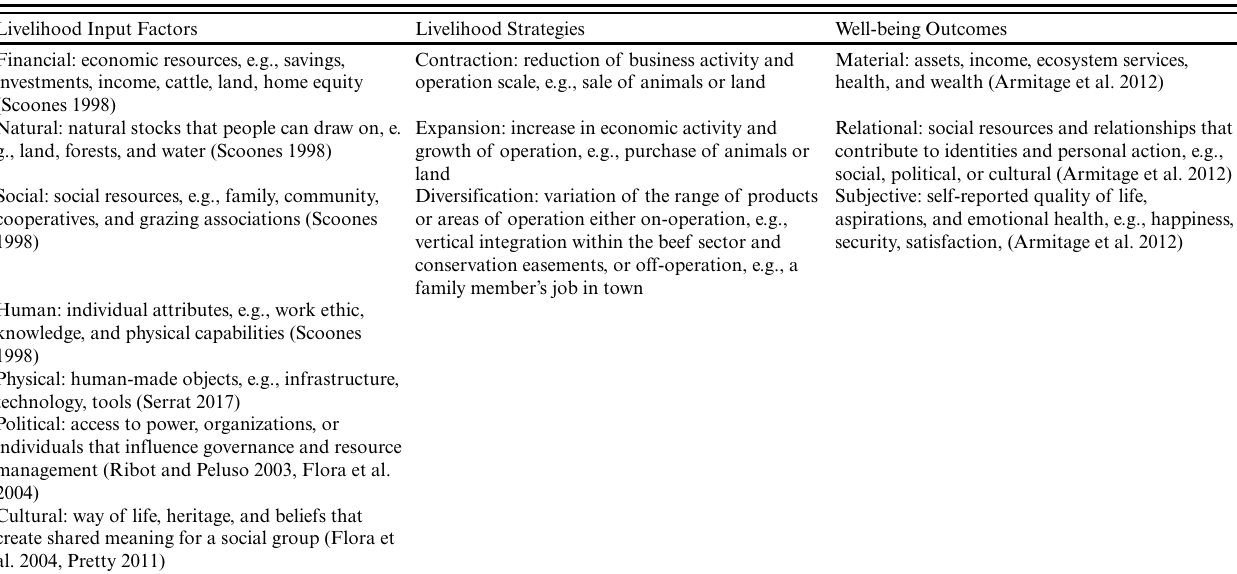
Table 2 . Overview of the livelihood input factors, livelihood strategies, and well-being outcomes. Given our inductive approach, all components emerged from our data, and we subsequently explored their presence in the literature. Livelihood Input Factors Livelihood